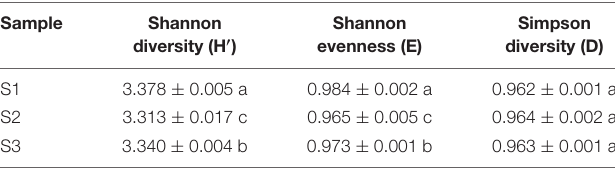
Data in the table are mean ± SE, n = 3. Using Duncan’s multiple range test of diversity indices separately, different letters of each column represent the significant difference at p < 0.05.